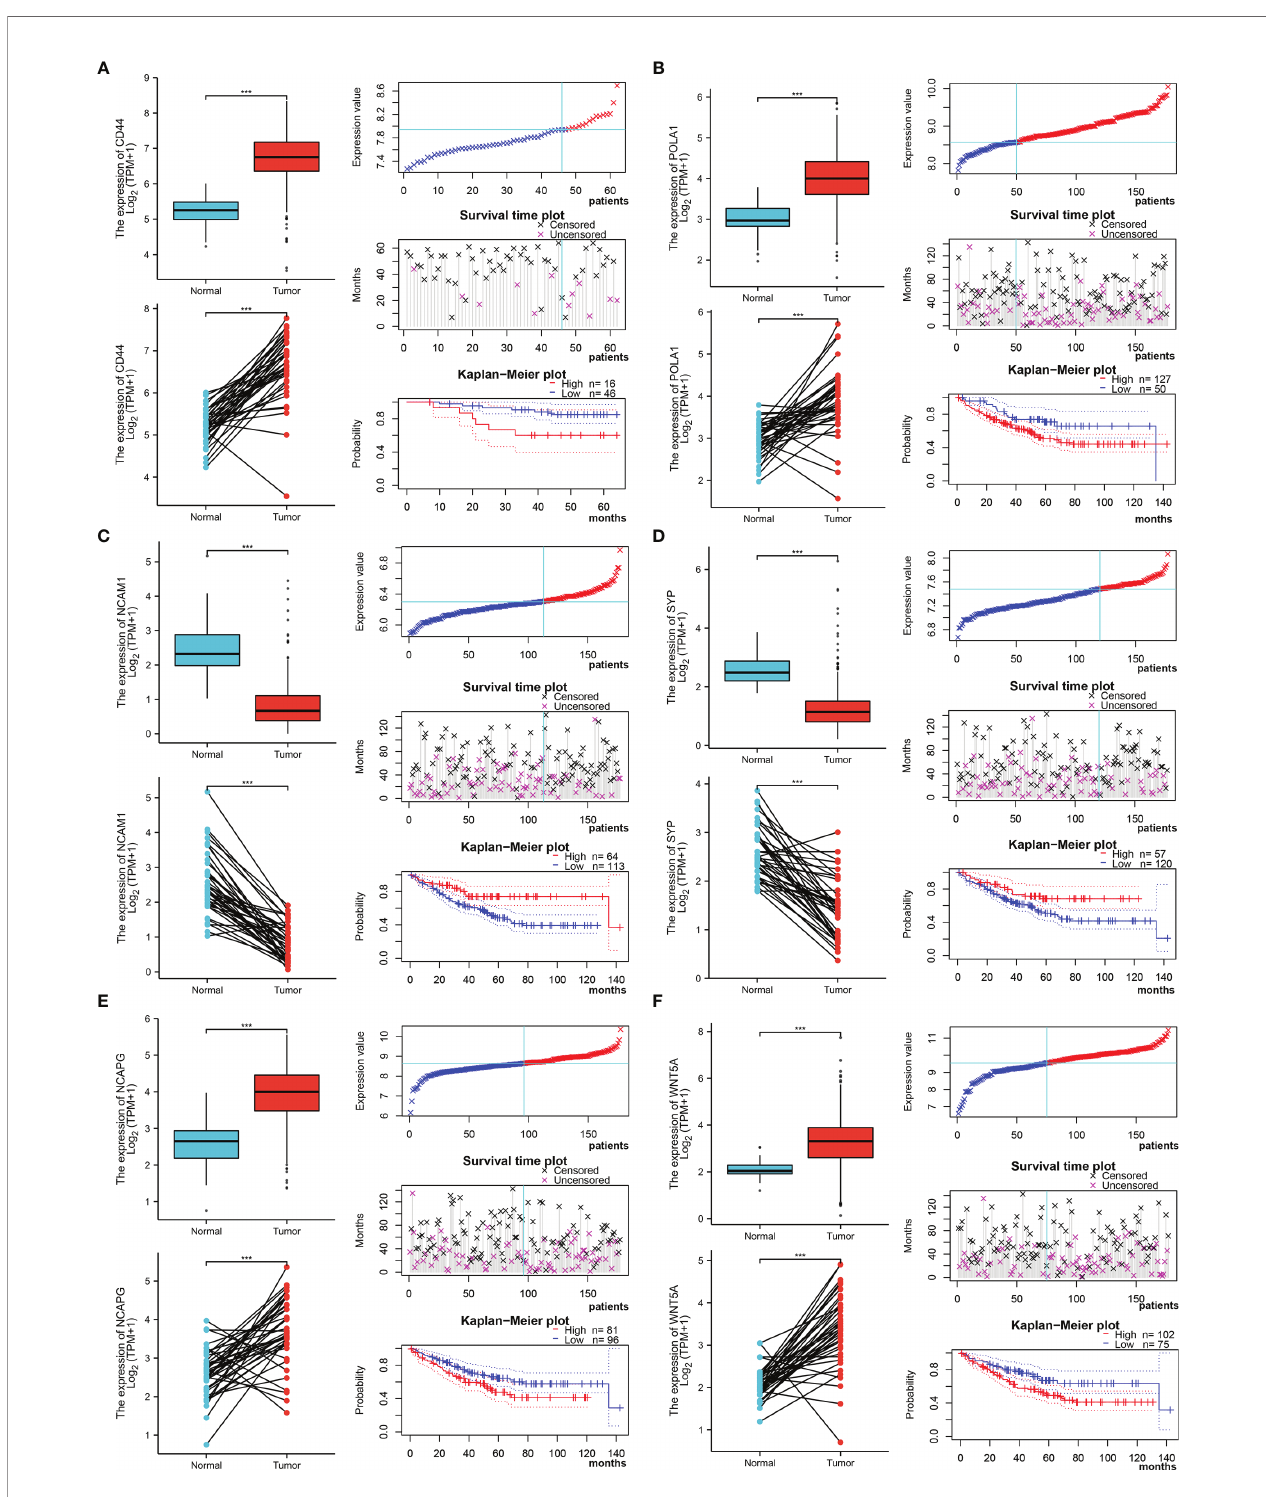
FIGURE 6 | Different expression and survival analysis of the hub genes by the Xiantao and PrognoScan search tools. (A) For CD44, (B) for POLA1, (C) for NCAM1, (D) for SYP, (E) for NCAPG, and (F) for WNT5A. (***p ≤